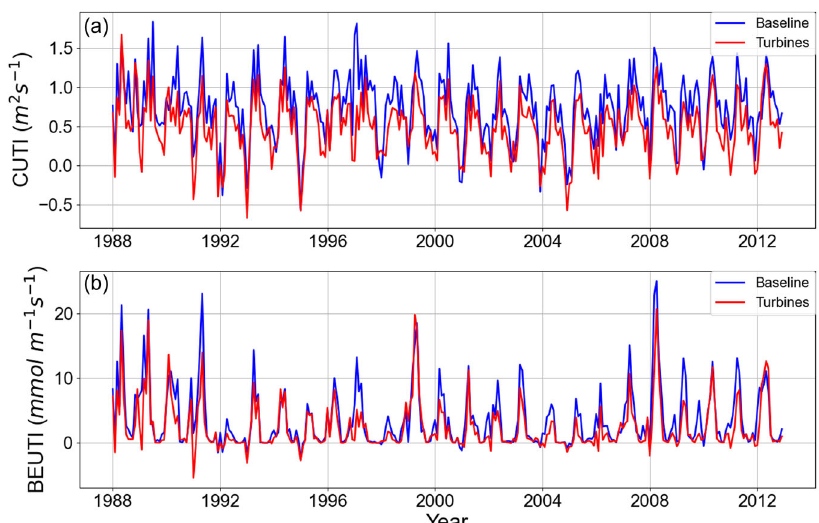
Fig. 6 Temporal evolution of upwelling metrics for volume transport and nutrient fl ux. a Coastal Upwelling Transport Index (CUTI) and b Biologically Effective Upwelling Transport Index (BEUTI) at 35°N, calculated over a 100 km zone.